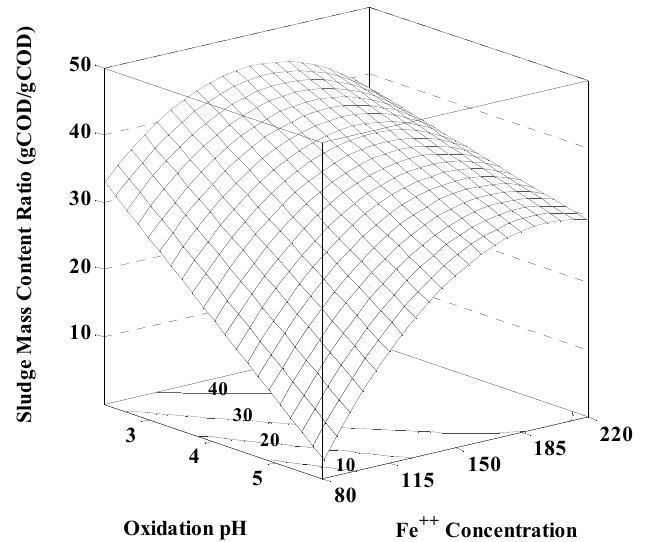
O ]/[Fe 2+ ] = 2 2 O ]/[Fe 2+ ] = 12) 2 2